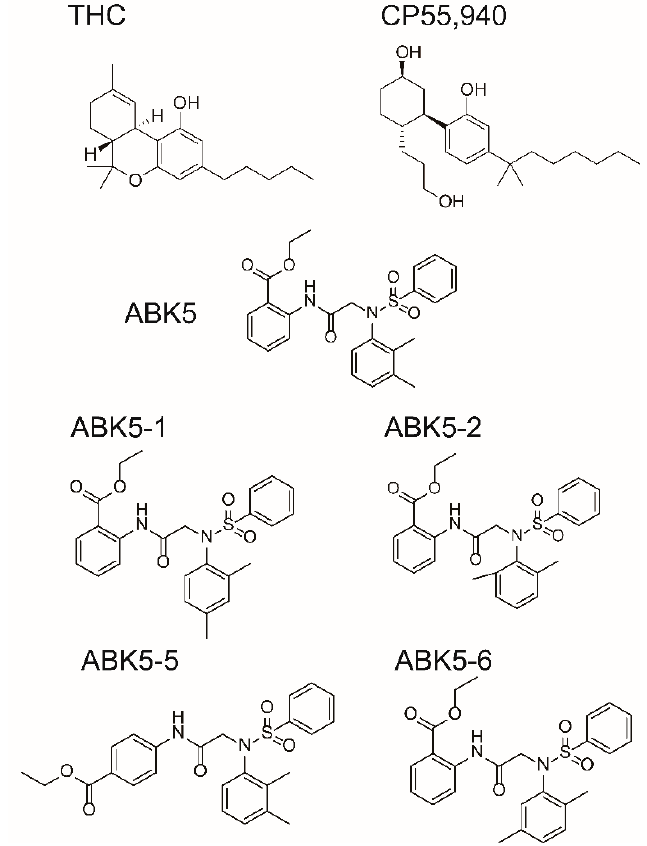
Figure 1. Chemical structures of some compounds that bind cannabinoid CB 1 or CB 2 receptors. Δ 9 - tetrahydrocannabinol (THC) and CP55,940 are agonists that bind both CB 1 and CB 2 . ABK5-1, ABK5-2, ABK5-5, and ABK5-6 are examined in this study.